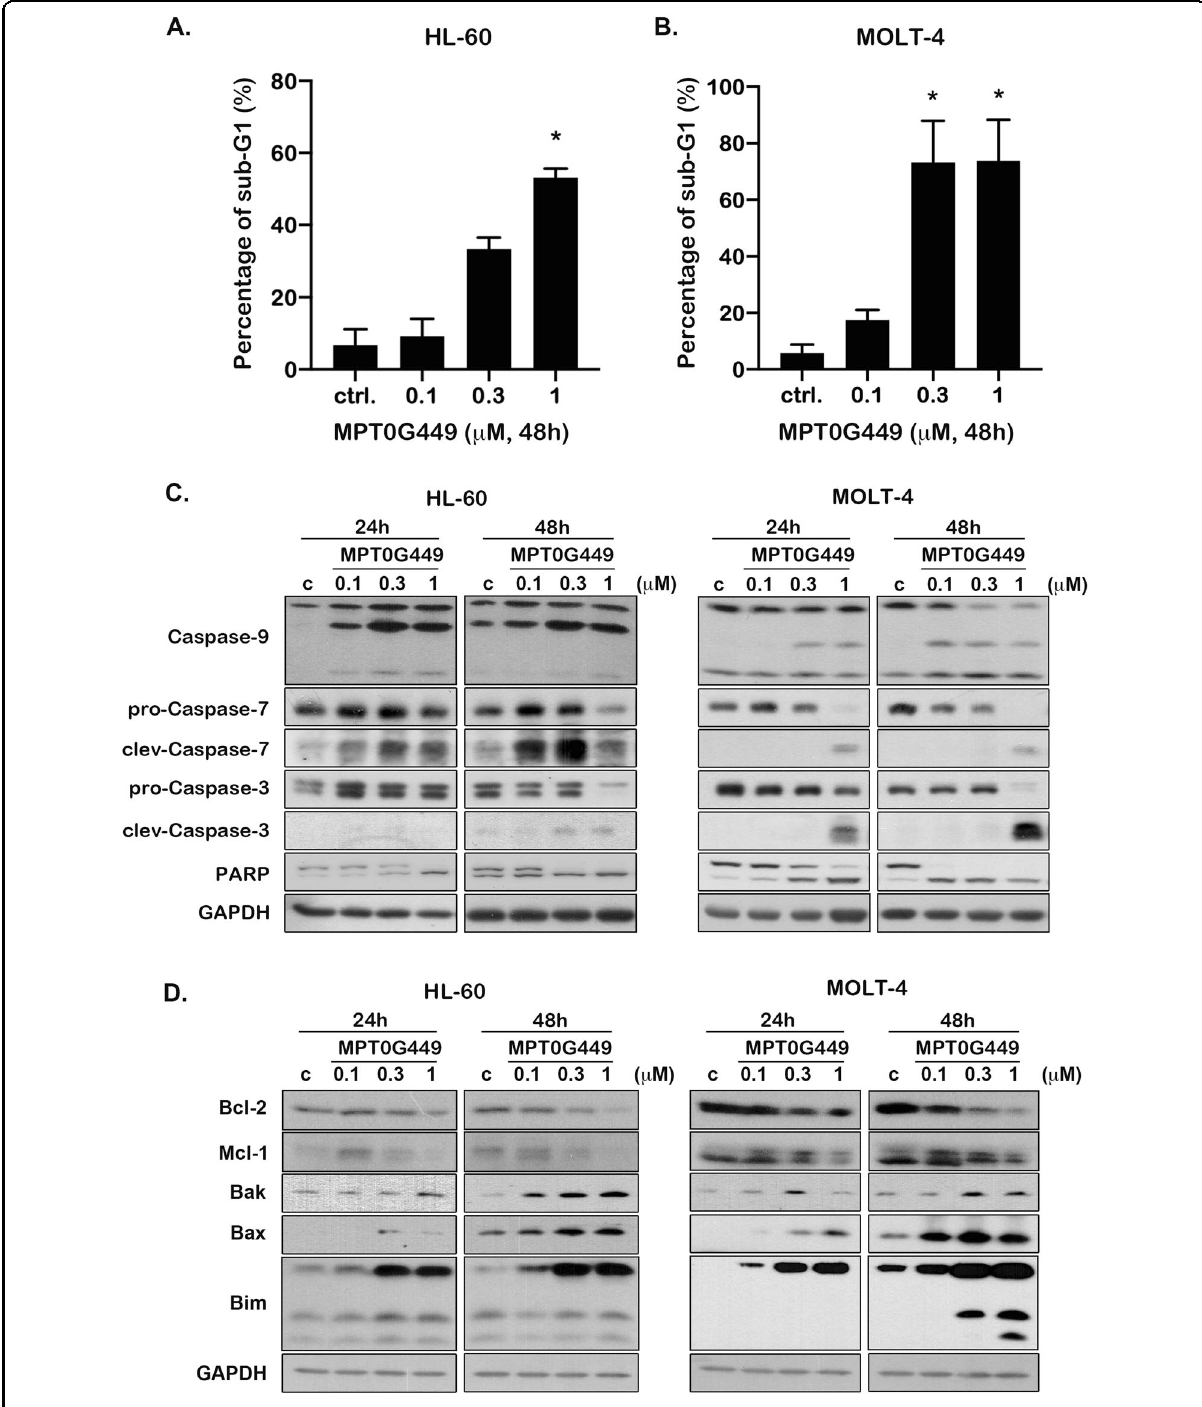
Fig. 4 MPT0G449 induces cell apoptosis and activates apoptotic protein expression in HL-60 and MOLT-4 cells. HL-60 A and MOLT-4 B cells were treated with 0.1, 0.3, and 1 μ M MPT0G449 for 48 hours, and the sub-G1 phase was detected by fl ow cytometry. The results represent the mean ± SD of three independent experiments at ∗ p < 0.05 compared with the control (c, untreated) group. ( C , D ) HL-60 and MOLT-4 cells were treated with various concentrations of MPT0G449 (0.1, 0.3, 1 μ M) for 24 and 48 h. Cells were then harvested for detection of caspase-9, caspase-7, caspase-3, and PARP activation C . After 24 and 48 h MPT0G449 treatment, the level of Bcl-2 related signaling (Bcl-2, Mcl-1, Bak, Bax, and Bim) were then determined D . The whole-cell lysates were subjected to western blotting, and the data were repeated at least three independent